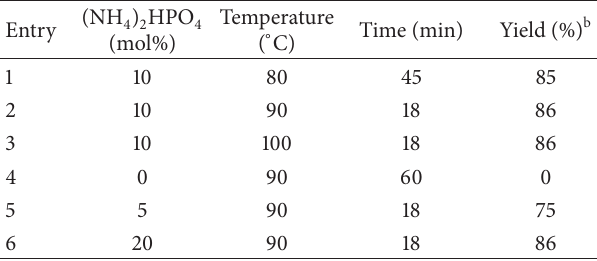
Table 1: Effect of different reaction conditions on synthesis of 5- arylidenerhodanines a .